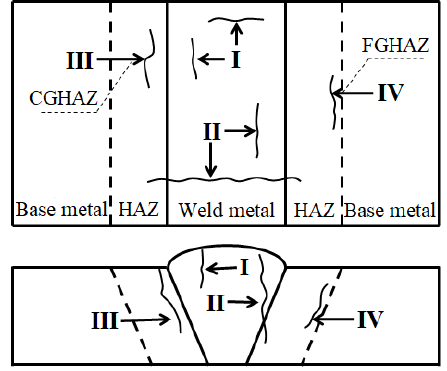
Figure 1. Crack classification of Cr-Mo steel welded joint, reproduced from [5], with permission from